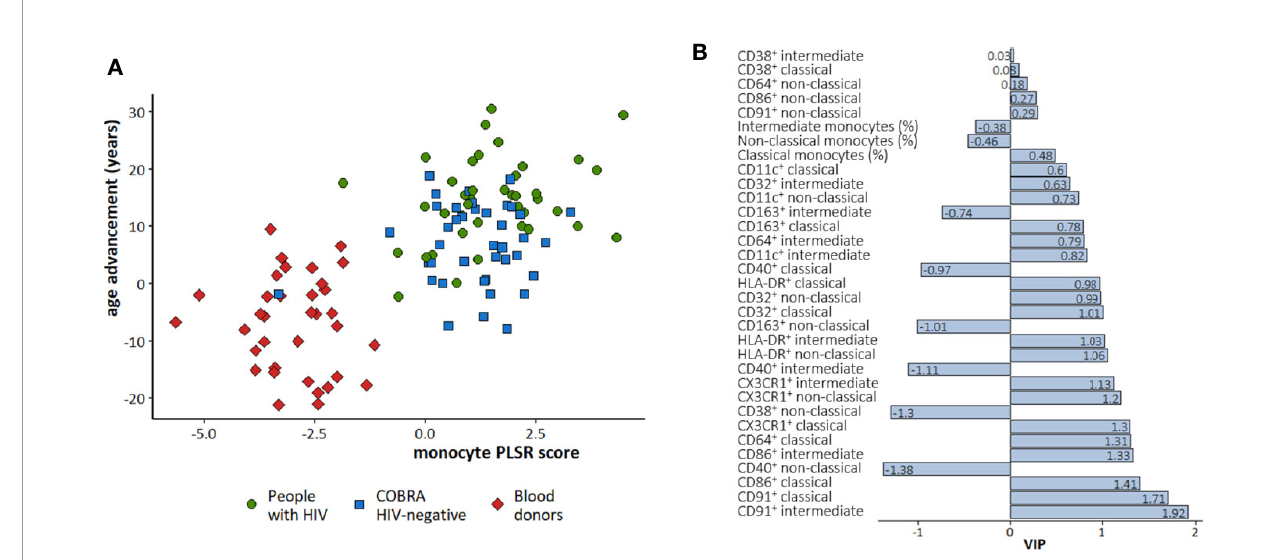
FIGURE 2 | Partial least squares regression (PLSR) to predict age advancement with monocyte markers in the three study groups combined. (A) Scatter plot of the PLSR score obtained and age advancement. Green circle: People with HIV; Bleu square: COBRA HIV-negative individuals; Red diamond: Blood donors. (B) Variable Importance in Projection (VIP) values for each monocyte marker. A negative VIP indicates that decreased levels of the speci fi c marker is associated with increased age advancement. A positive VIP indicates that increased levels of the speci fi c markers is associated with increased age